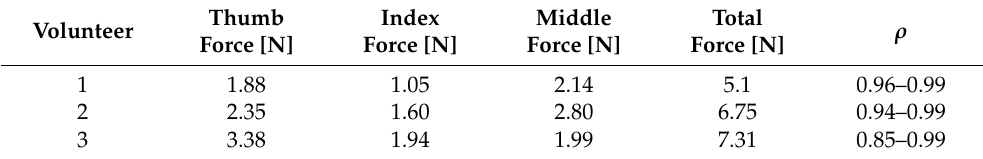
Table 2. Force increments generated by the motors and correlation coefficients for each volunteer.